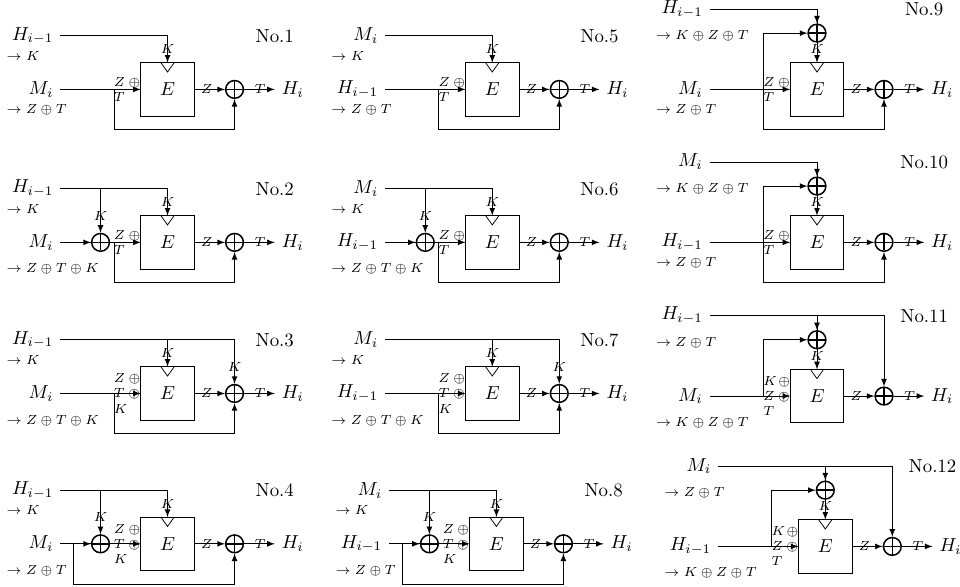
Figure 13: Equivalence among difference PGV modes for our attacks Sect. 3.2 applies directly without any modification to the case of converting pseudo-preimage attack into a second-preimage